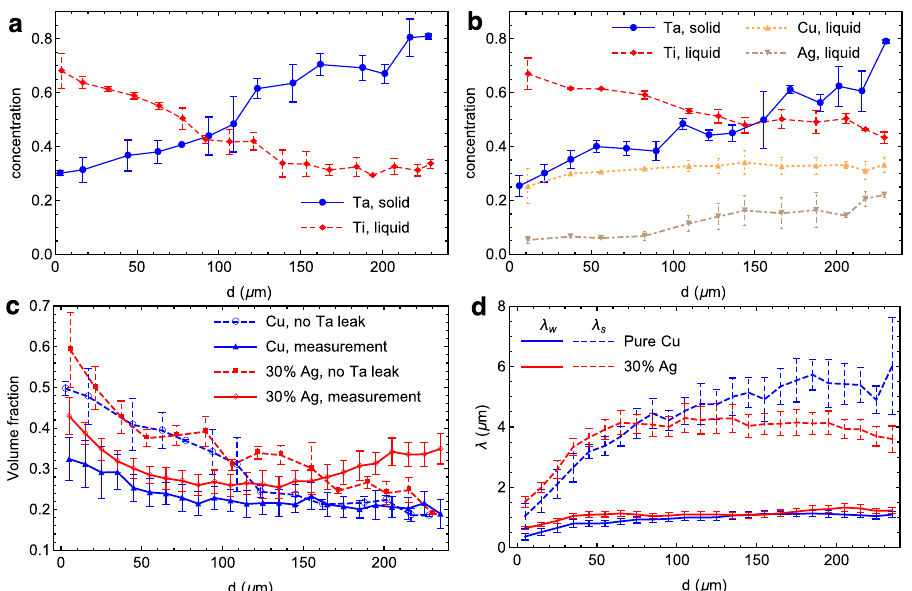
Fig. 5 Characterization of dealloyed layers. Measured concentration pro fi les as a function of distance d from the dealloying front for Ta 15 Ti 85 alloys dealloyed in pure Cu melts ( a ) and Cu 70 Ag 30 melts ( b ). Comparison of measured solid volume fraction of dealloyed structures ρ ( d ) (solid lines) and the theoretical prediction without Ta leak (dashed lines) corresponding to Eq. (1) ( c ); the overestimation of the prediction of Eq. (1) at the dealloying front is corrected by Eq. (2) that takes into account Ta leak. Measured average ligament width λ w and spacing λ s ( d ). Error bars represent the standard